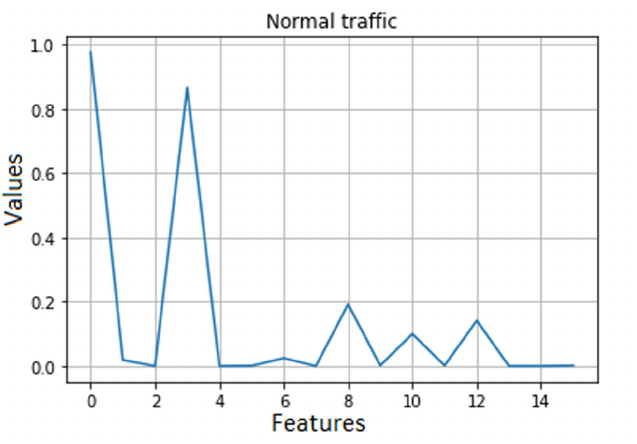
Figure 4. Values for one normal data record from the training dataset.